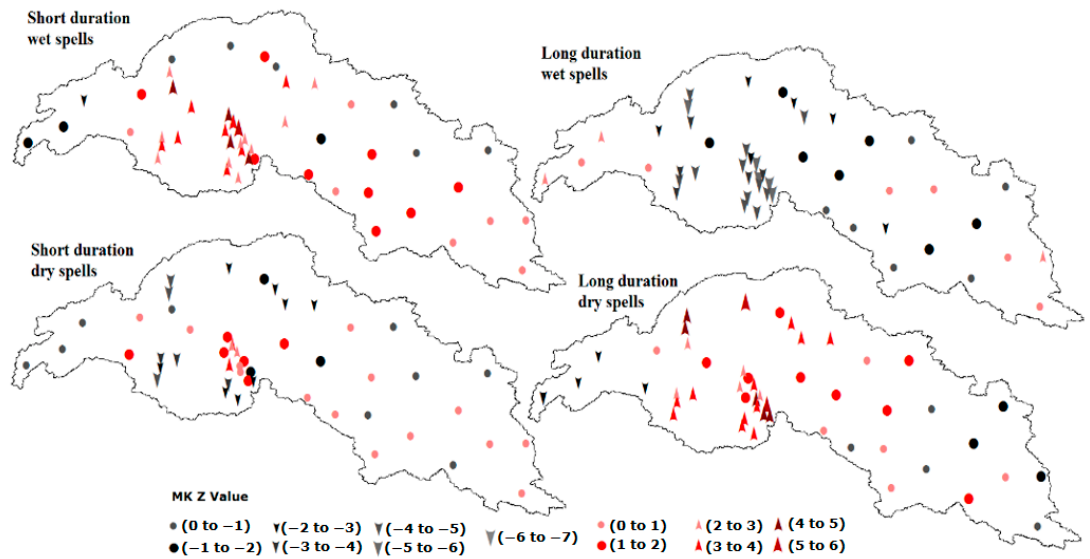
Figure 10. Trend analysis of short- and long-duration wet and dry spells in the study area.